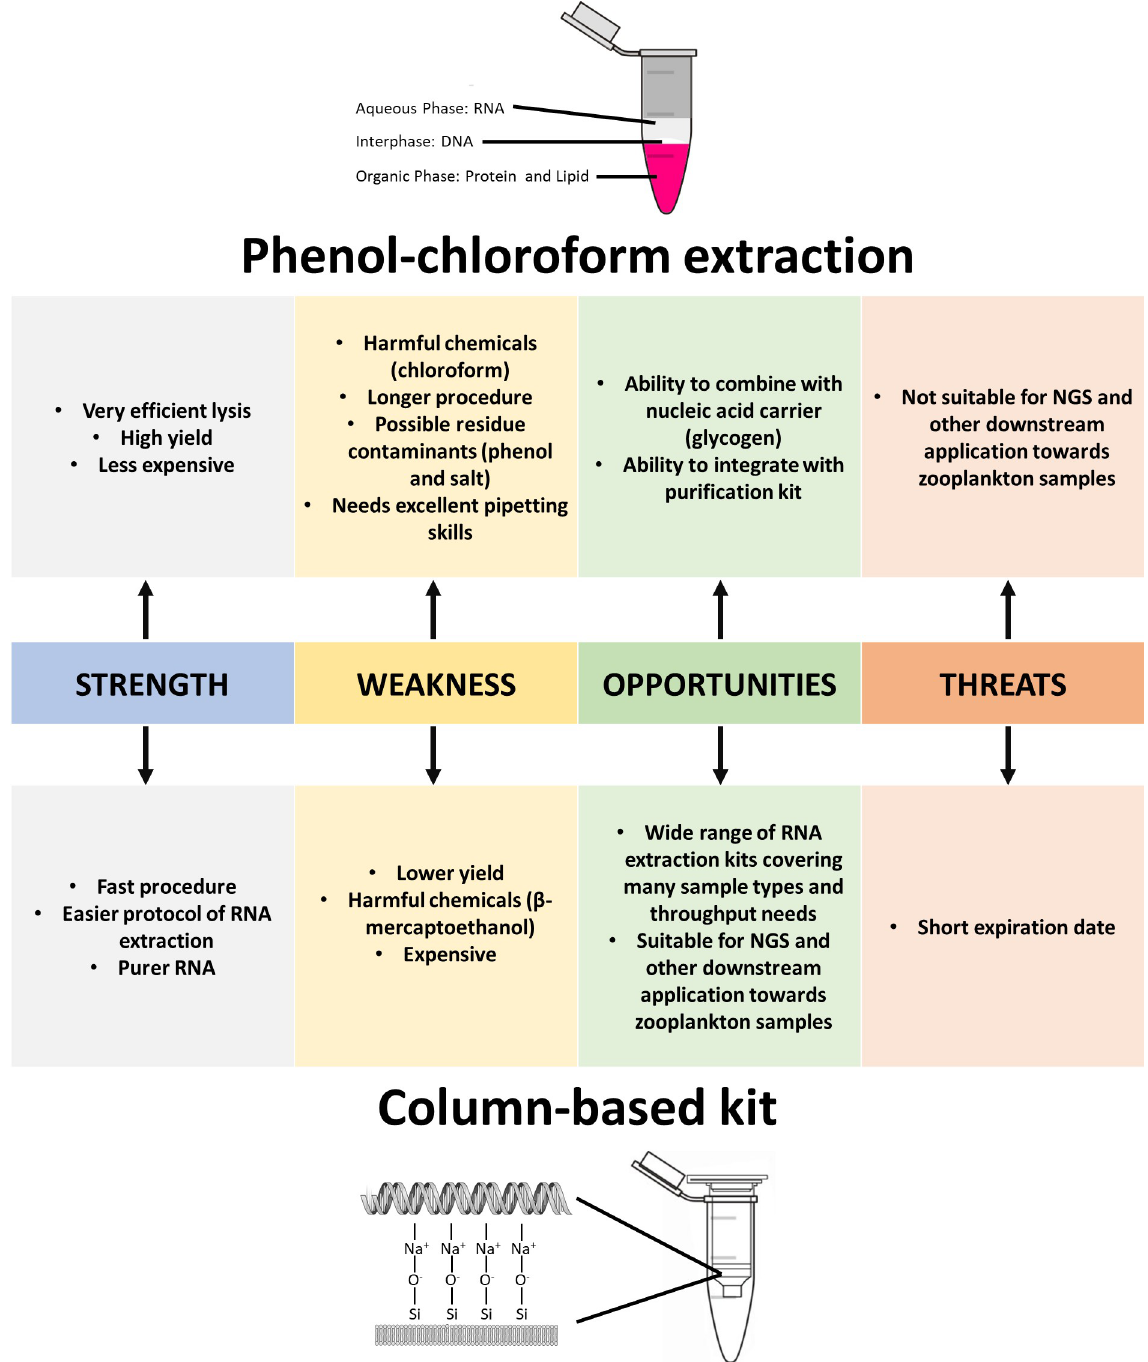
Fig 6. SWOT analysis of the phenol-chloroform extraction method and the column-based kit for the RNA extraction of zooplankton